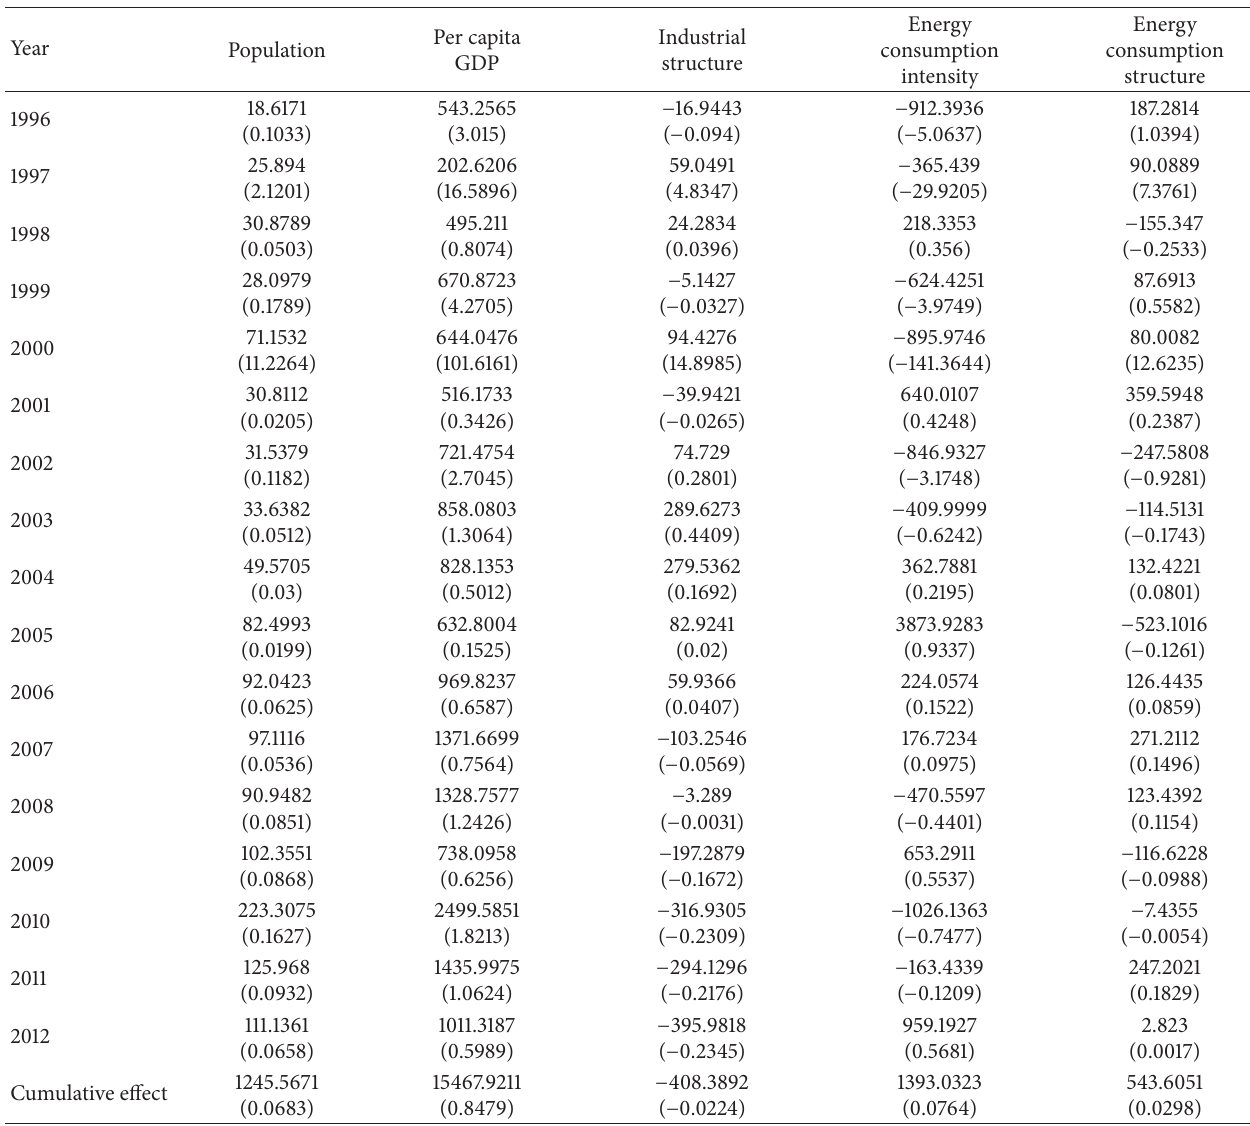
Table 5: Effects of different factors of carbon emissions from energy consumption of Shandong province from 1996 to 2012 by combination